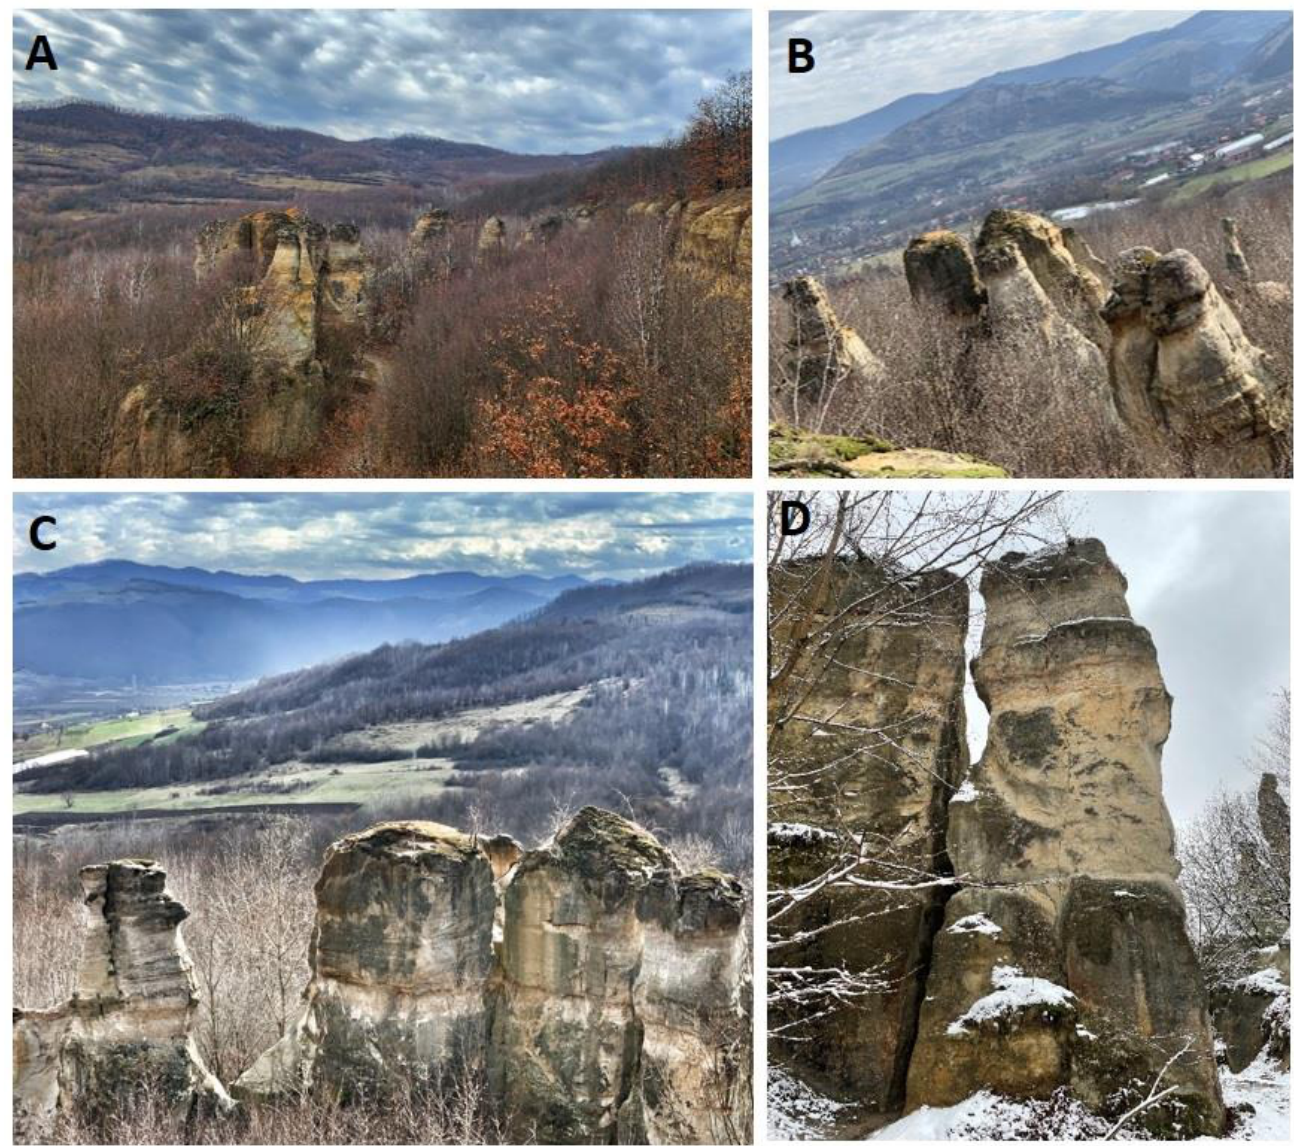
Figure 2. ( A ) Panoramic view, ( B ) Horea, Cloșca and Crișan, Acul Cleopatrei, ( C ) Turnuri. ( D ) Zmeul and Zmeoaica.